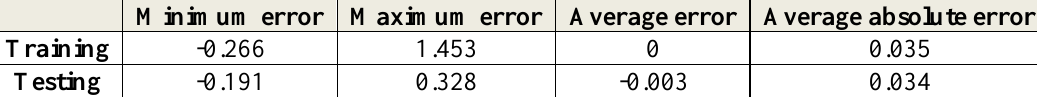
Table 7. Selecting the best network structure for prediction.